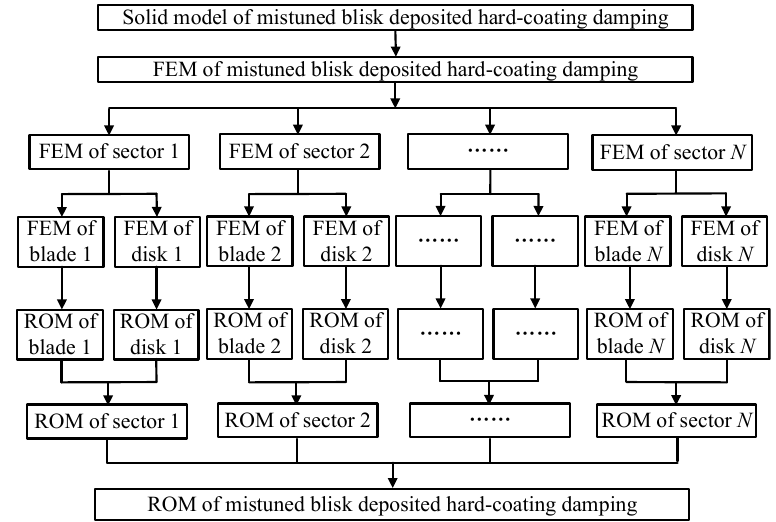
Figure 3. Fundamental principle of the improved component modal synthesis method (ICMSM) for the HCM blisk. ROM, reduced ‐ order model.